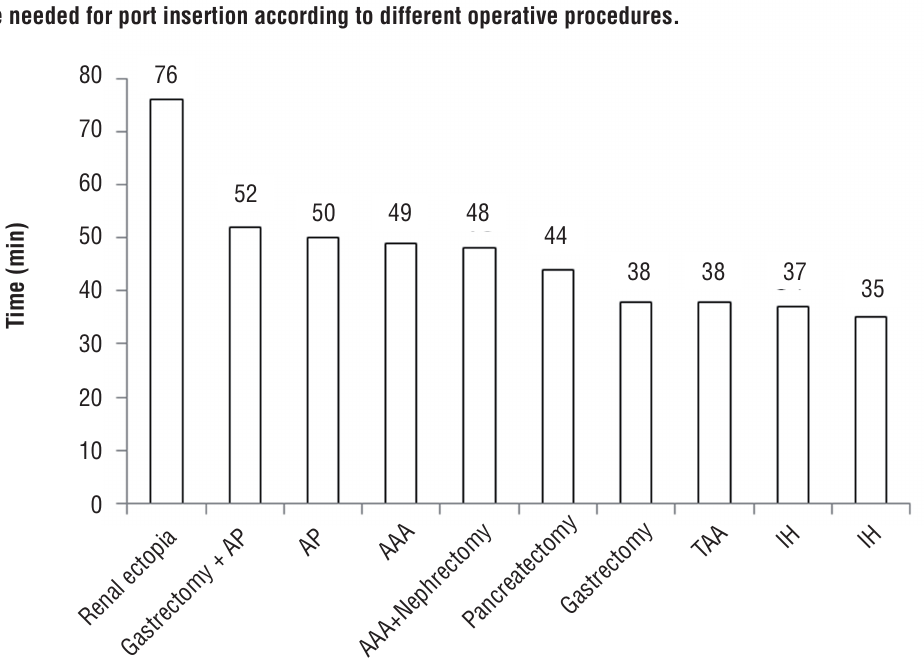
Figure 1 - Time needed for port insertion according to different operative